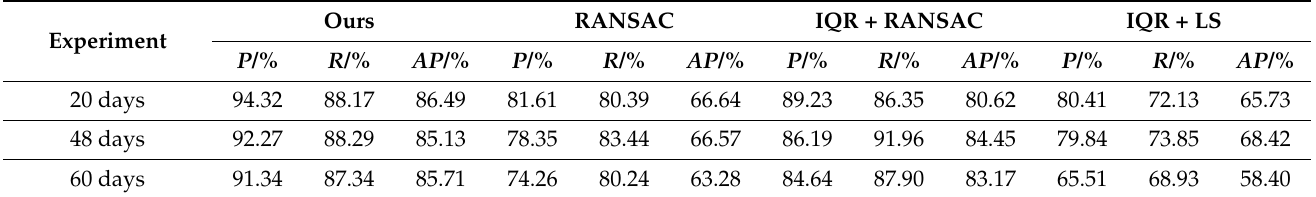
Table 3. Comparison of evaluation indexes of different ground surface filtering